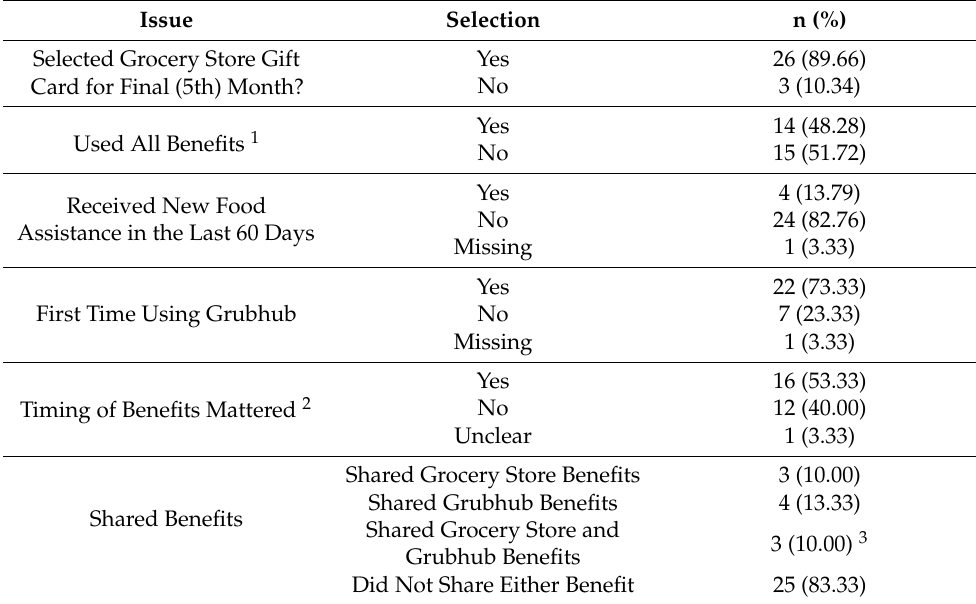
Table 2. Food benefit issues and preferences (n =